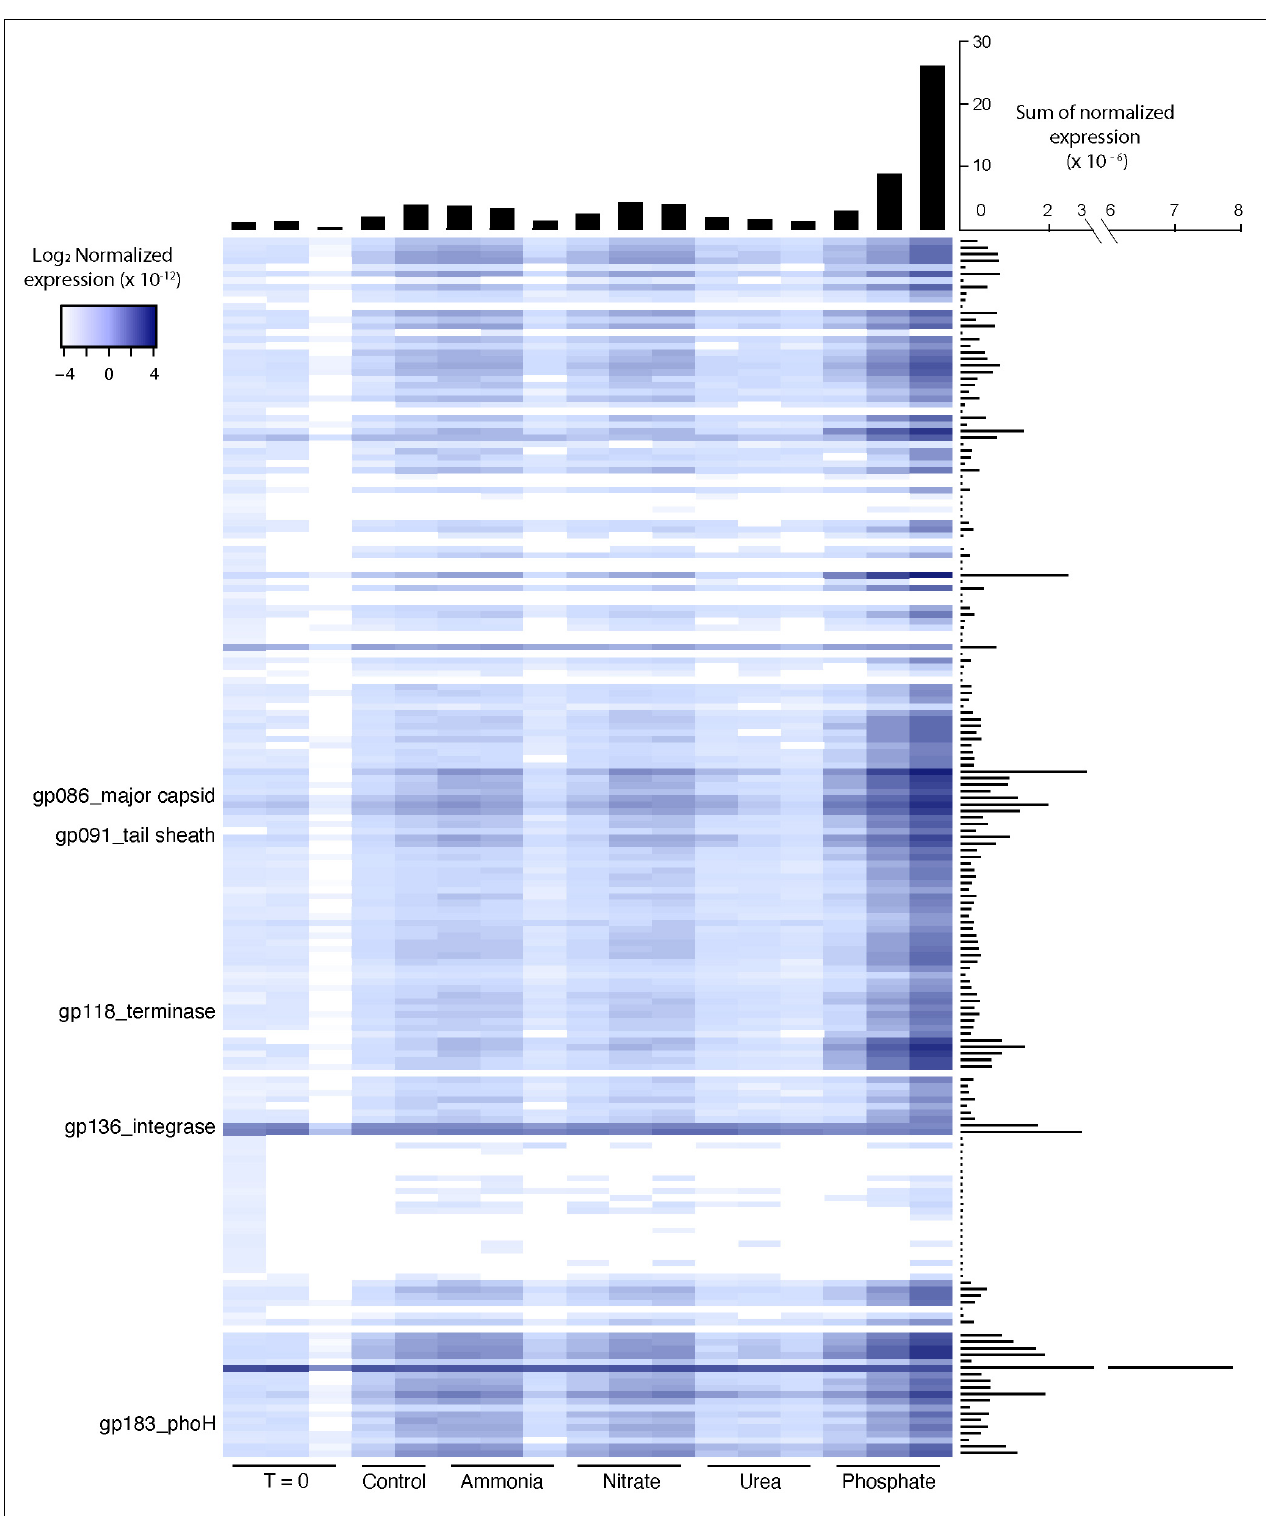
FIGURE 3 | Heatmap of normalized expression for Microcystis phage Ma-LMM01 genes in individual experimental bottles. Histograms describe the sum of normalized expression for each bottle (horizontal histogram) and each gene (vertical histogram). Expression was normalized to the library size of each sample and the length of each